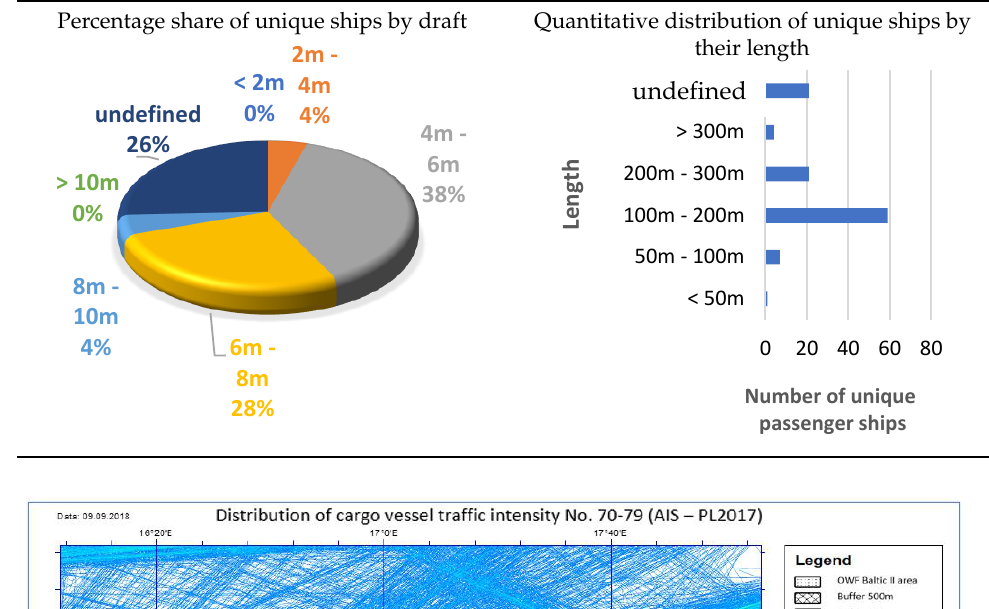
Table 5. Quality characteristics of passenger ships.